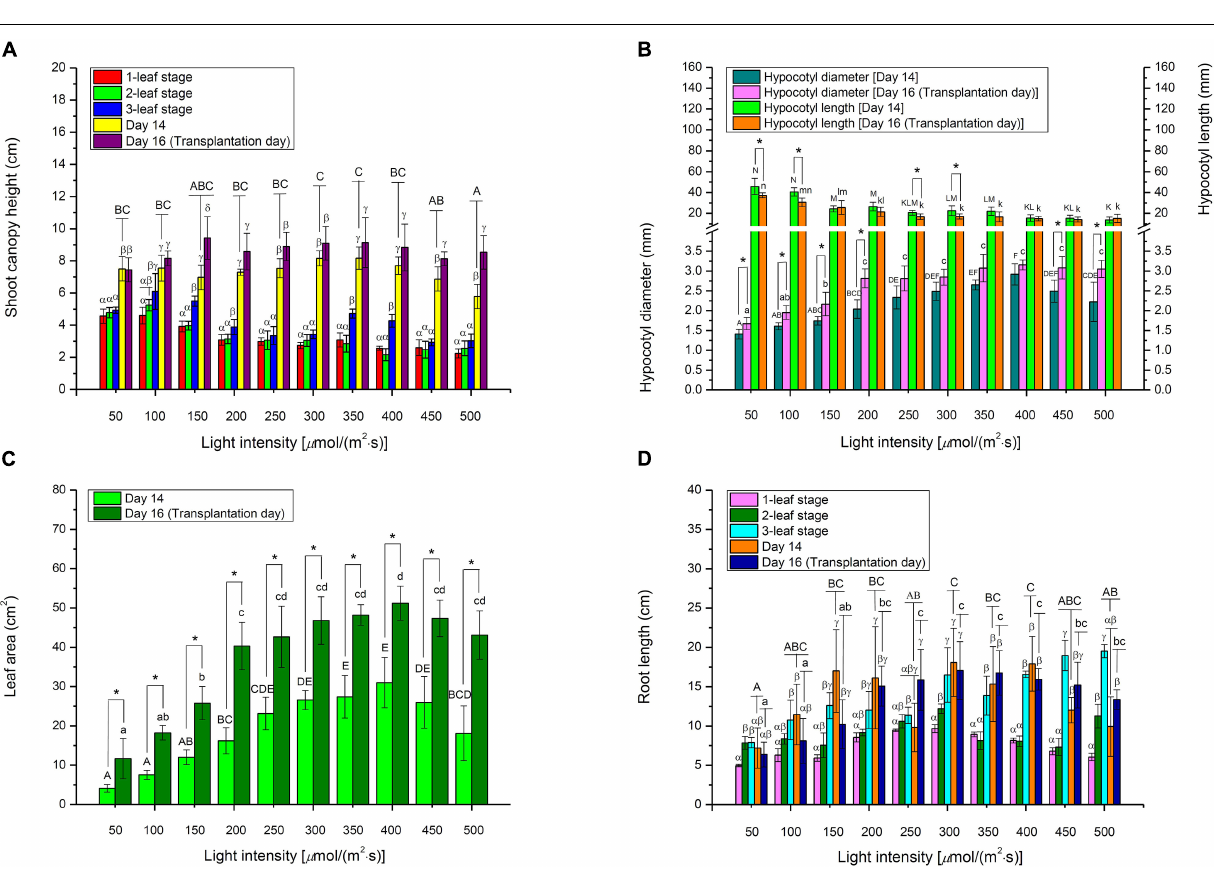
Frontiers in Plant Science |